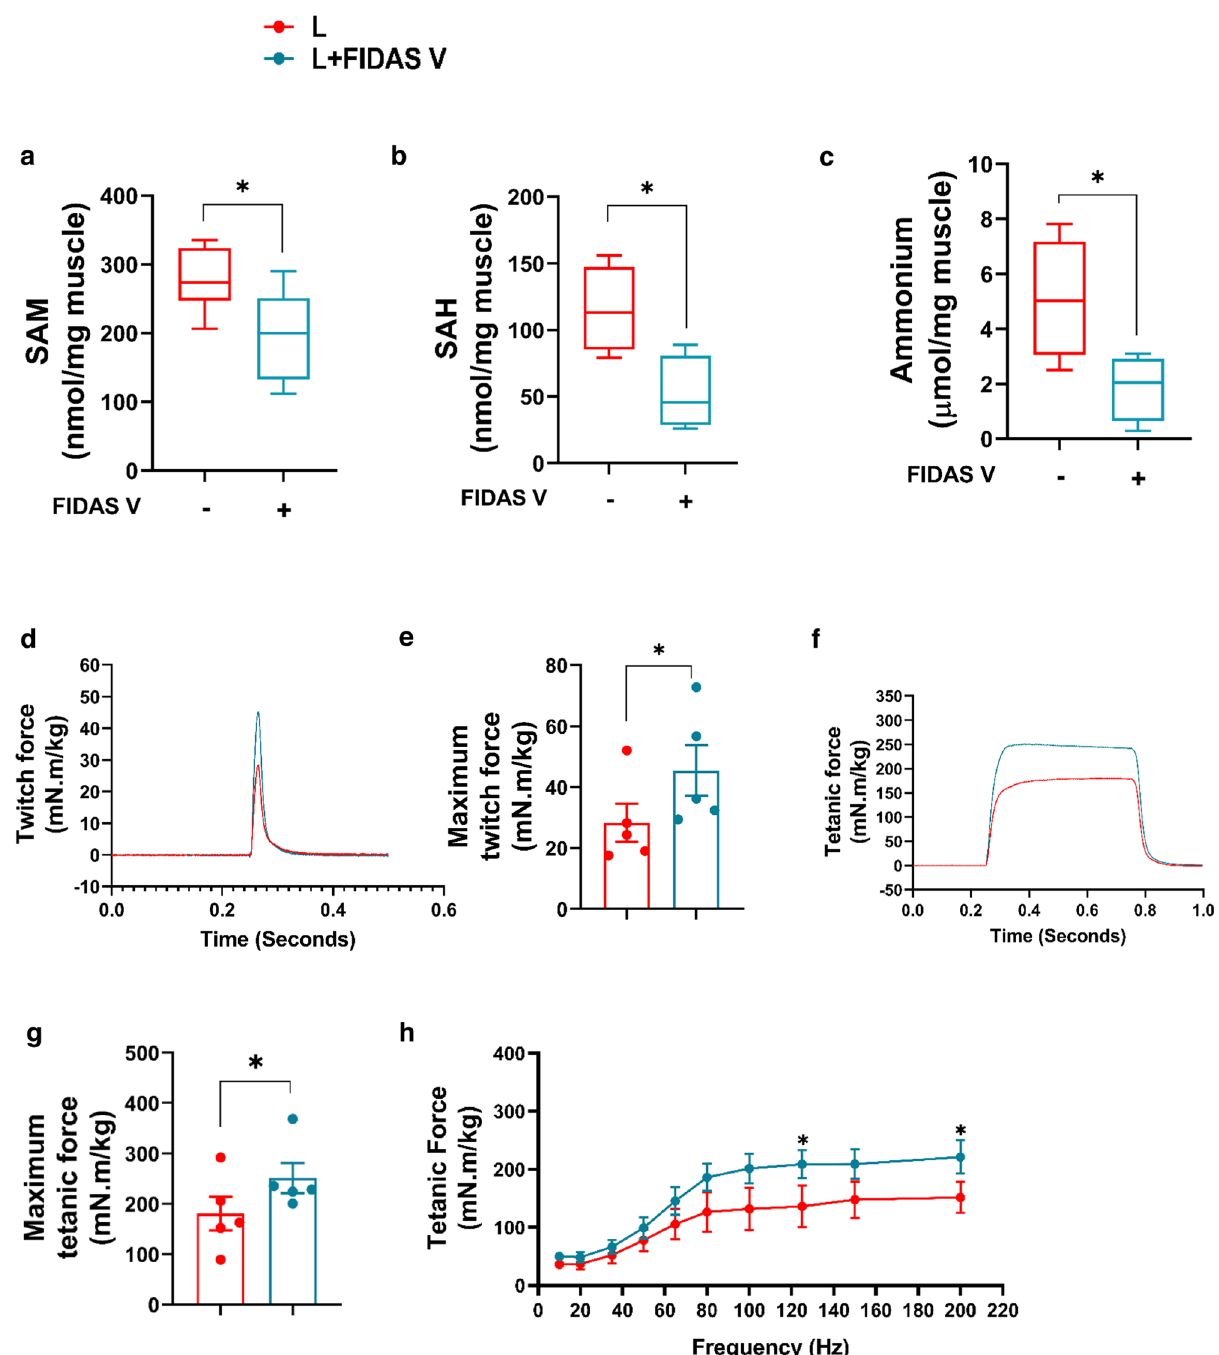
Fig. 9 | MAT2A inhibition increases contraction force generation by LAKI mousemuscle in vivo.a – c Effect of FIDAS V on s -adenosyl methionine (SAM), s -adenosylhomocysteine (SAH), and ammonium production in TA muscle. Statistical signi fi cance using unpaired t -test (Plot a; * p = 0.03, b: * p = 0.02, c: * p =0.04). d , e Effect of FIDAS V on twitch force * p = 0.046 using paired t - test. f – h Effect of FIDAS V on tetanic force contraction pro fi le ( f ), maximum tetanic force (* p = 0.019 using paired t -test) ( g ), and tetanic force as a func- tion of stimulation frequency (* p =0.04 using two-way ANOVA with Tukey ’ s